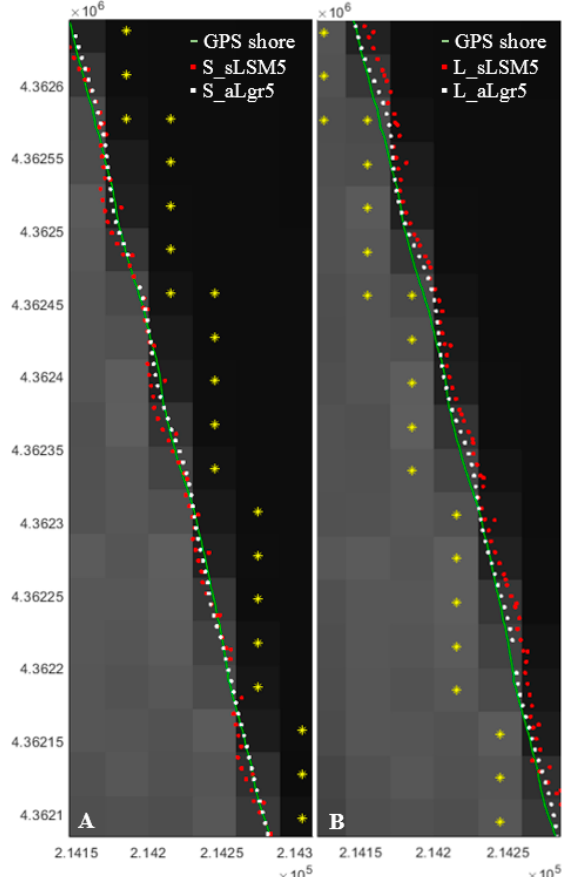
Figure 11. Map with sub-pixel shoreline solutions for 2 June 2016 of El Saler beach shown over the corresponding L8 (SWIR1 band) image. These are compared with the GPS shoreline representing the same instantaneous water line (continuous green line). The sub-pixel methodological process starts from an initial shore (whose pixels are tagged in yellow) biased seaward ( A ) and landward ( B ). Red points are computed with sLSM5 method and black points with aLgr5 method. The grid coordinates are GCS_ETRS89 UTM31N.